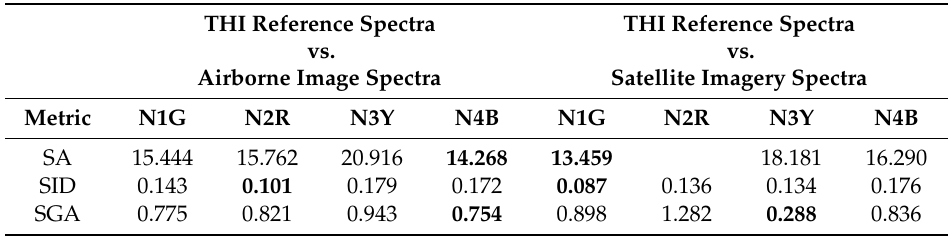
Table 3. Spectral similarity between the THI target reference spectra and the corresponding airborne, and space-borne target image spectra (SA is measured in degrees and SGA in radians). Values in bold are statistically significant.